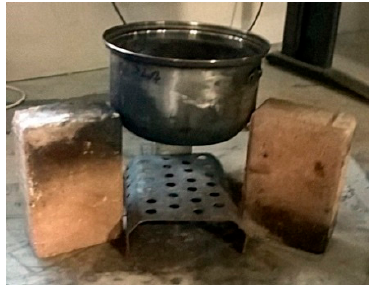
Figure 1. The Mewar Angithi (MA) inserted in a three-stone fire.